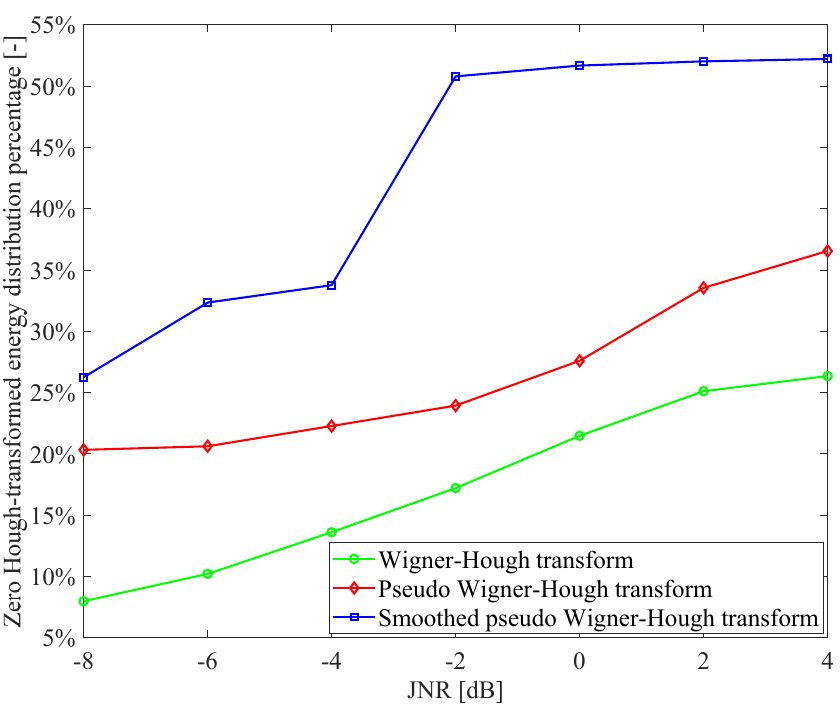
Figure 16. The zero Hough-transformed energy percentage metrics of the Hough transform based GNSS interference detection techniques.